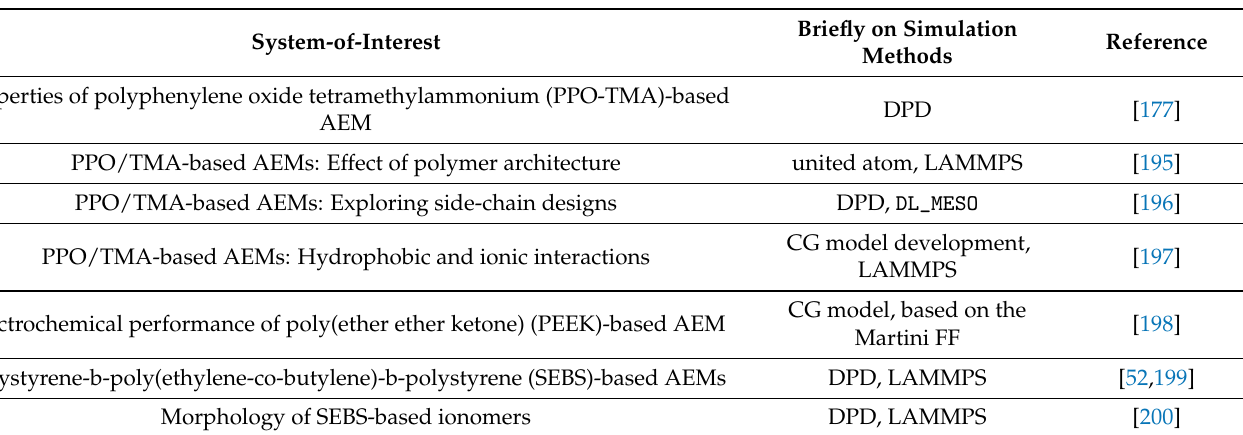
Table 4. Recent CGMD studies on AEM-related systems